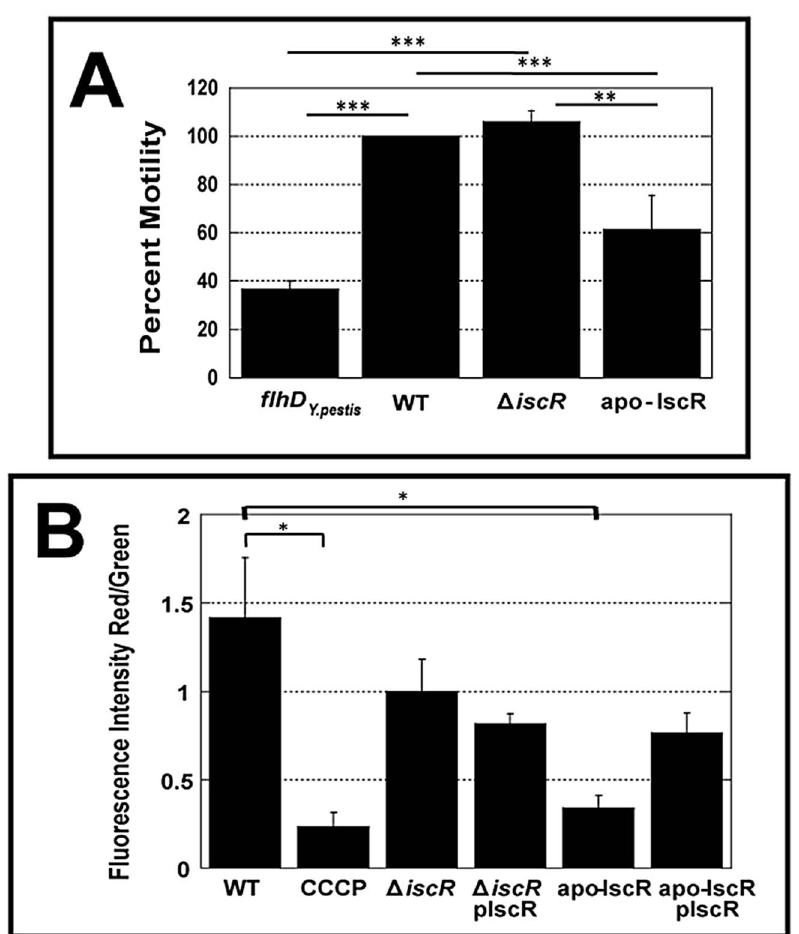
Figure 6. The apo-IscR mutant strain displays decreased motility and disruption of electrical potential. ( A ) Motility was analyzed by spotting 1 m l aliquots of either a nonmotile strain ( D yop6/ flhD Y.pestis ), WT, D iscR , or apo-locked IscR Y. pseudotuberculosis onto motility agar plates. The diameters of the colonies were determined one day later and used to calculate percent motility relative to WT, which was set at 100%. Shown is the average percent motility 6 SEM and is representative of three independent experiments. ***p # 0.0001 as determined by one-way ANOVA followed by Bonferroni post hoc test where each indicated group was compared to the appropriate negative ( D yop6/ flhD Y.pestis ) and positive (WT) controls. ( B ) Proton motive force (PMF) was measured using JC-1 dye for Y. pseudotuberculosis IP2666 wild type (WT), iscR deletion mutant ( D iscR ), iscR complemented ( D iscR pIscR), apo-IscR, and apo-IscR complemented (apo-IscR pIscR) strains grown in M9 at 37 u C for 3 hours. The protonophore CCCP was added to a WT sample as a negative control (CCCP). Decreases in PMF were measured as a decrease in red (590 nm) fluorescent cells relative to green (530 nm). The data is presented as total fluorescence intensities at 590 (red) relative to 530 (green) 6 SEM and is representative of three independent experiments. *p # 0.05, as determined by one-way ANOVA followed by Bonferroni post hoc test where each indicated group was compared to the appropriate negative (CCCP) and positive (WT) controls.